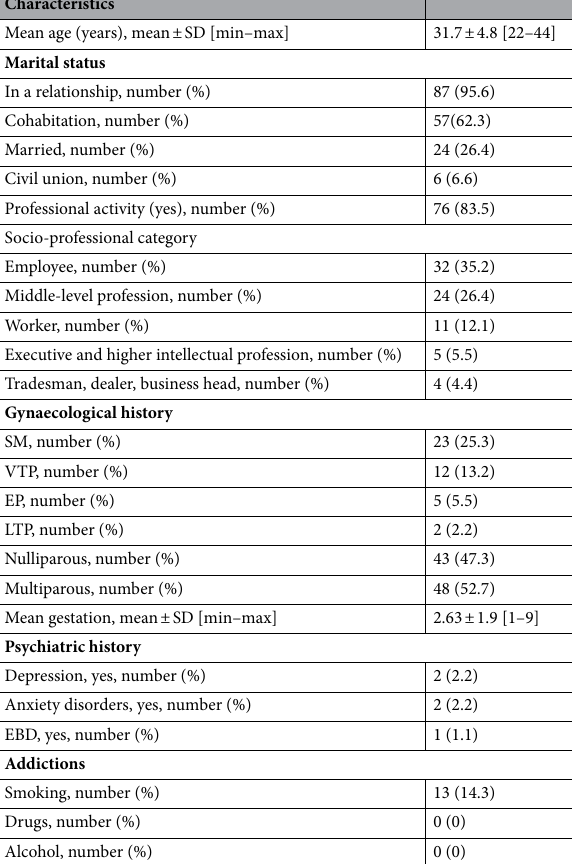
Table 1. Population characteristics (n = 91) M1. % percentage, SD Standard Deviation, VTP Voluntary termination of pregnancy, LTP Medical termination of pregnancy, SM Spontaneous miscarriage, EP ectopic pregnancy, EBD Eating Behaviour